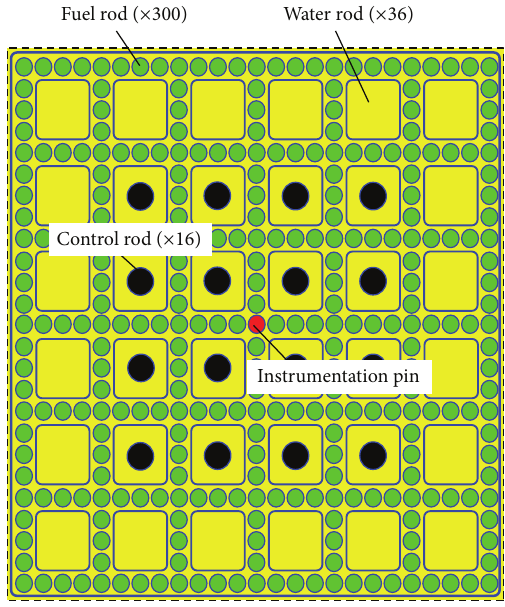
Figure 3: The cross sections assembly of U.S. reference design